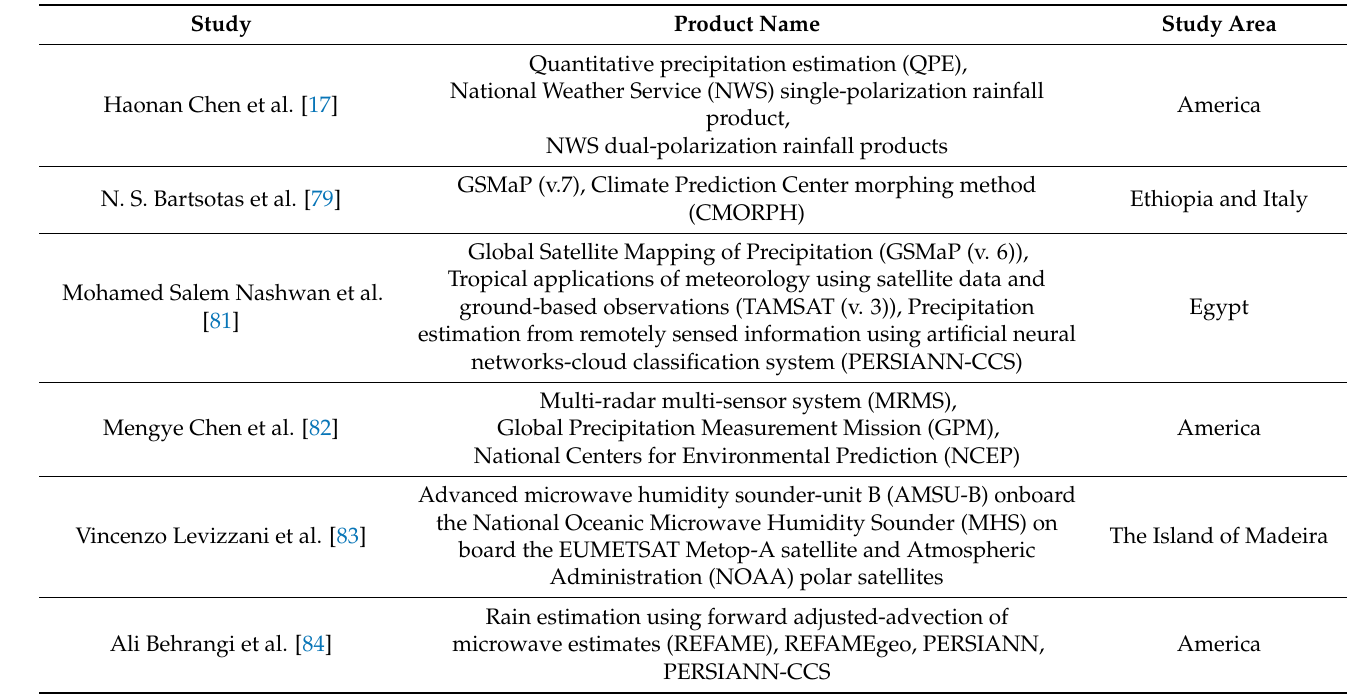
Table 2. For evaluating satellite precipitation